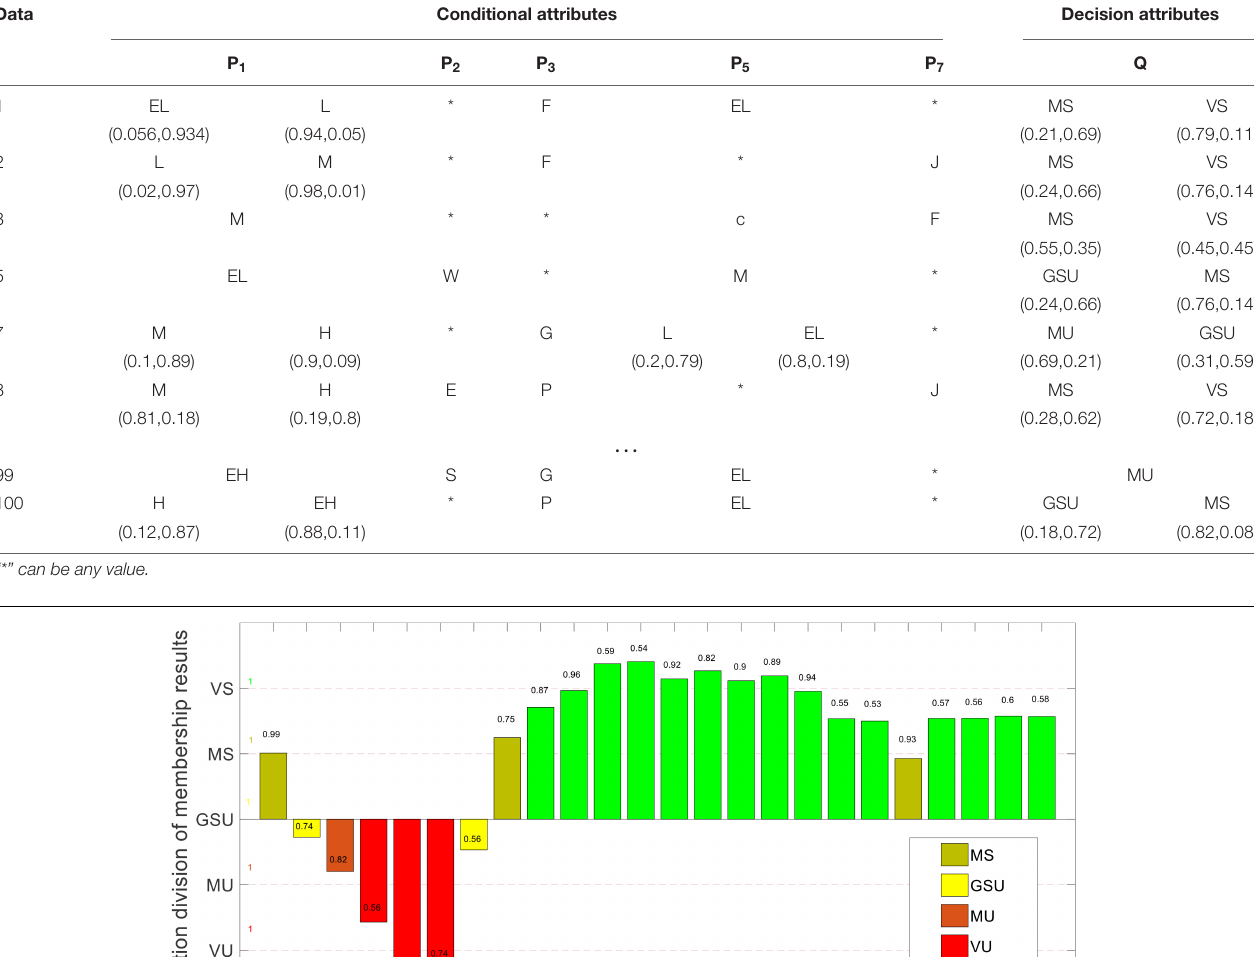
TABLE 5 | Decision rule attributes table.